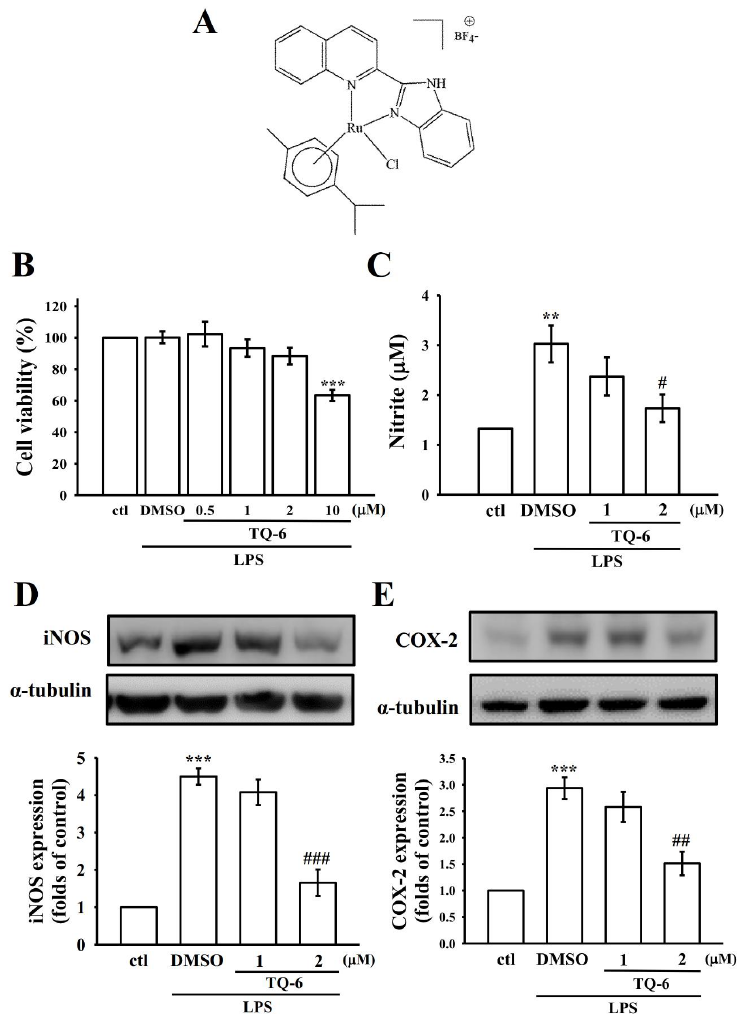
Figure 1. Effects of [Ru( η 6-cymene)2-(1H-benzoimidazol-2-yl)-quinoline Cl]BF4 (TQ-6) on cell viability, nitric oxide (NO) production, inducible nitric oxide synthase (iNOS), and cyclooxygenase 2 (COX-2) expression in lipopolysaccharide (LPS)-stimulated microglia. ( A ) Chemical structure of TQ-6. Cells were pretreated with TQ-6 (0.5–10 µ M) or 0.1% dimethyl sulfoxide (DMSO) for 30 min and then treated with LPS (1 µ g / mL) for 24 h to measure ( B ) cell viability using a 3-(4,5-dimethylthiazol-2-yl)-2,5-diphenyltetrazolium bromide (MTT) assay, ( C ) NO (nitrite) by using a Griess reagent, and ( D ) iNOS or ( E ) COX-2 protein expression by using an immunoblotting assay. Data are presented as mean ± standard error of the mean (SEM; n = 4); ** p < 0.01 and *** p < 0.001 compared with control (ctl); # p < 0.05, ## p < 0.01, and ### p < 0.001 compared with the LPS-treated